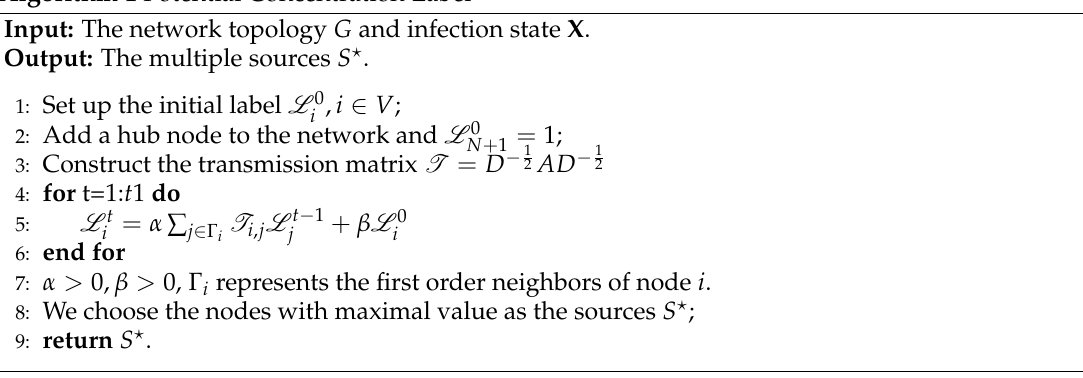
Algorithm 1 Potential Concentration Label